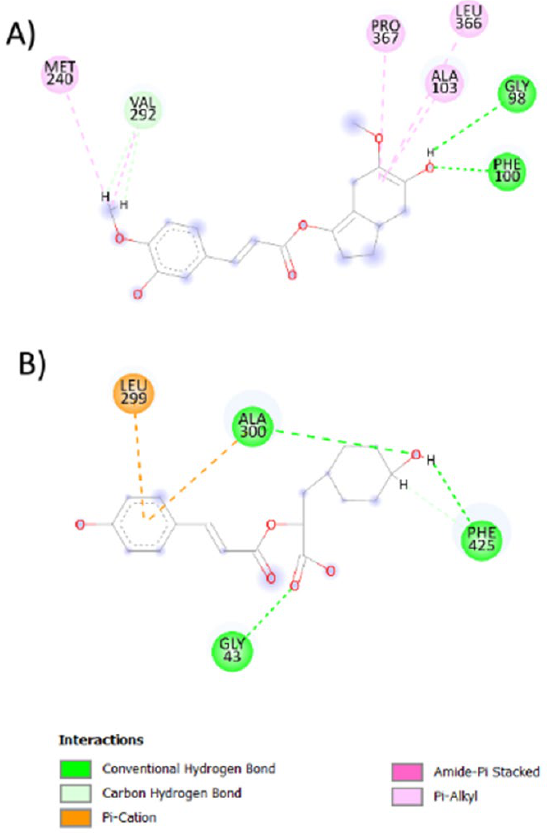
Figure 5. 2D representation of the best-coupled interactions. ( A ) Interaction of CYP450 with ros- marinic acid-derived compound (14 NP, ∆ G = − 8.617973). ( B ) Interaction of NO with rosmarinic acid-derived compound (6 APP, ∆ G = − 8 .725966).